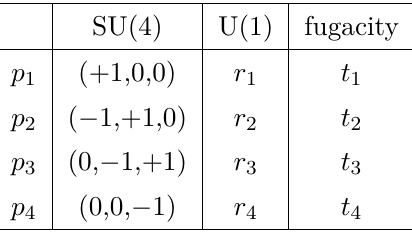
Table 6 . Global symmetry charges on the extremal brick matchings p i of Model